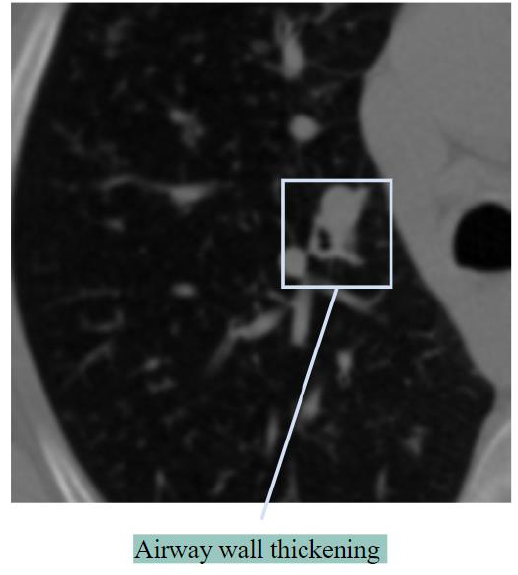
Figure 5. Airway wall thickening.